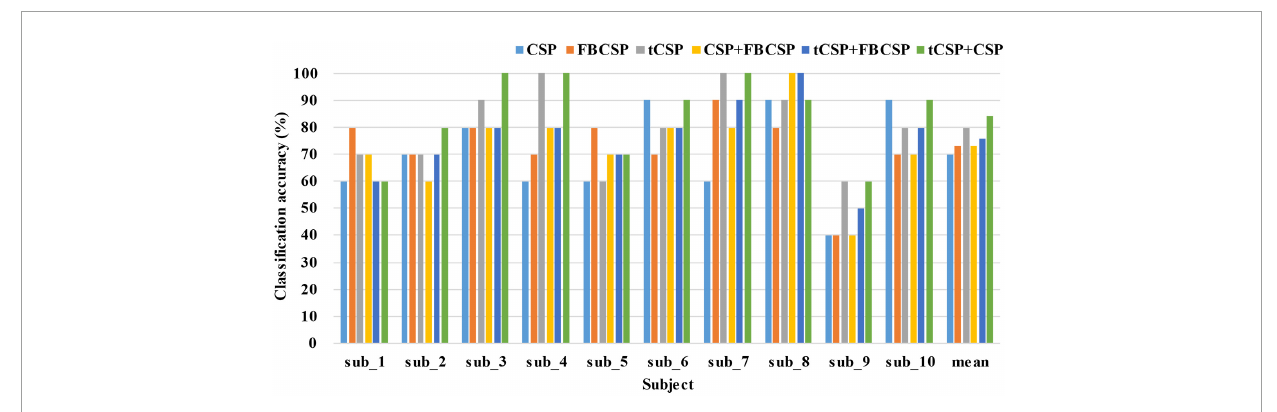
averaged across trials of subject S9. The four segments before 10 s correspond to the first four eigenvectors of CSP filter W , and the last four segments correspond to the last four eigenvectors of W . The frequency ranges from 8 to 32 Hz. We can observe the spectral power increase in the mu band induced by the left- and right-hand MI tasks. Figure 4B shows waveforms of the templates at the optimal frequency point of subject S9. The templates are calculated according to Equation 10. The templates show a distinct discriminative ability for the left- and right-hand MI tasks. method’s effect further. Figure 5 displays the feature distribution maps transformed by t-SNE (Van der Maaten and Hinton, 2008) for subjects S2, S6, and S9 from experiment one. The features were extracted by CSP, FBCSP, and tCSP with 40 training samples ( Figure 5A ) and 8 training samples ( Figure 5B ) for each subject. The tCSP features of different MI tasks are more diverse than those of CSP and FBCSP. The two tasks could be better separated with more training samples for all